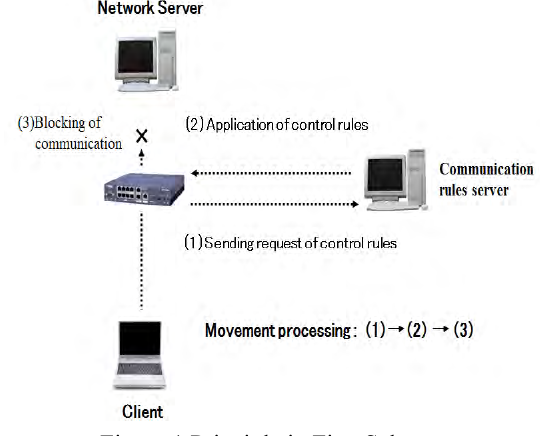
Figure 1 Principle in First